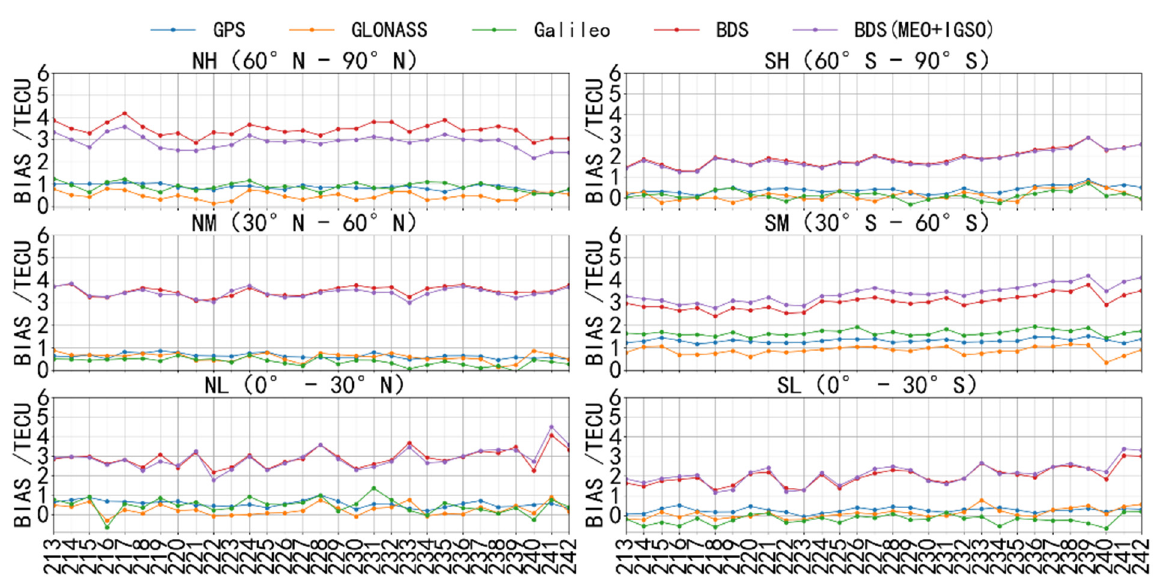
Figure 6. Biases between GIMs and CODE GIMs of four systems during ionospheric quiet days.